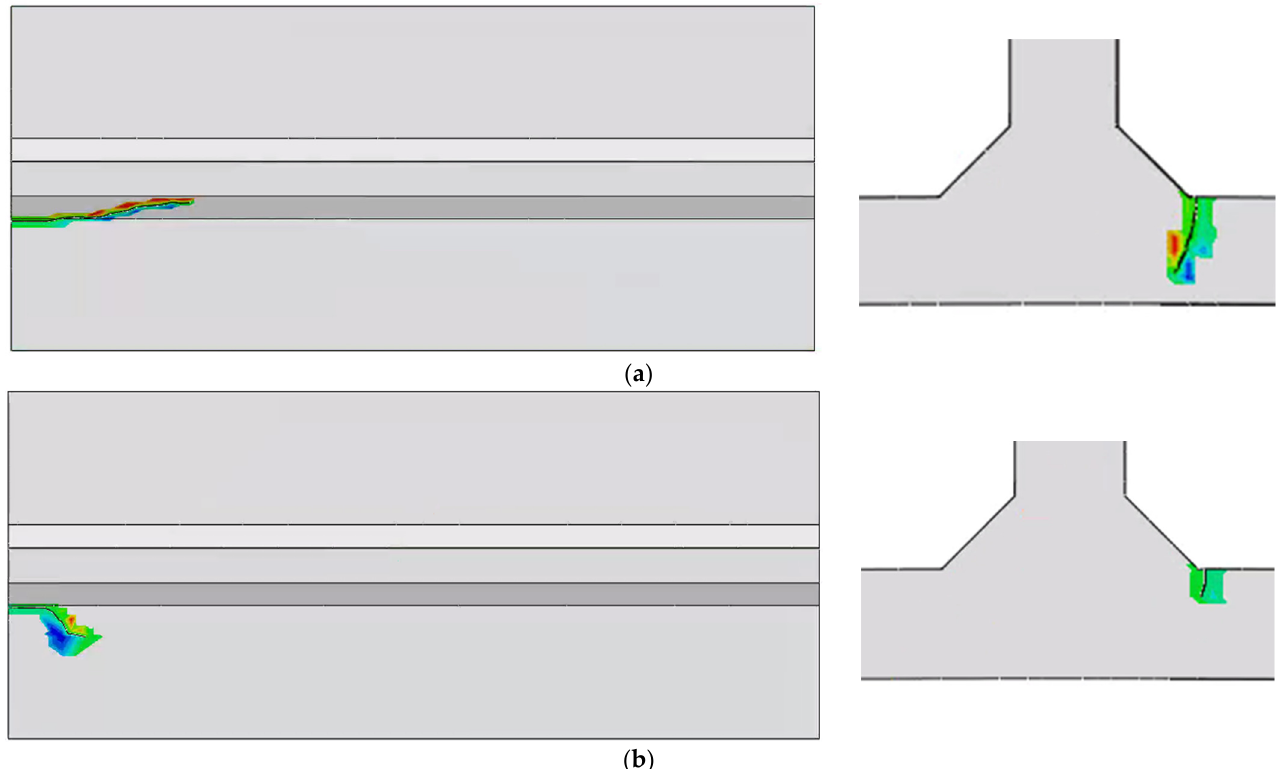
Figure 23. Crack propagation under a maximum displacement load of 0.35 mm when the initial crack is located in the start of the weld: ( a ) without a residual stress field at 81,566 cycles; ( b ) with residual stress field at 100,000 cycles.